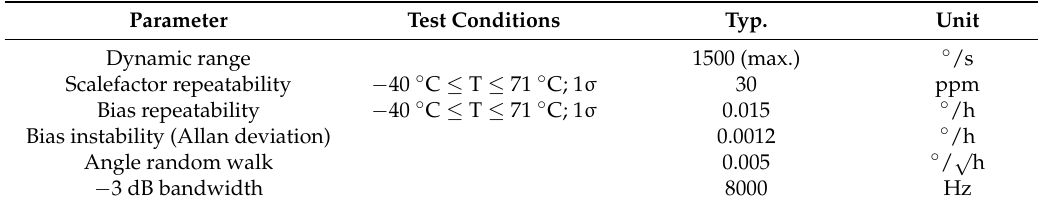
Table 3. Typical values achieved by single-axis FOGs for the use in the Northrop Grumman LITEFs FOG-IMU based systems. All parameters tested on the IMU